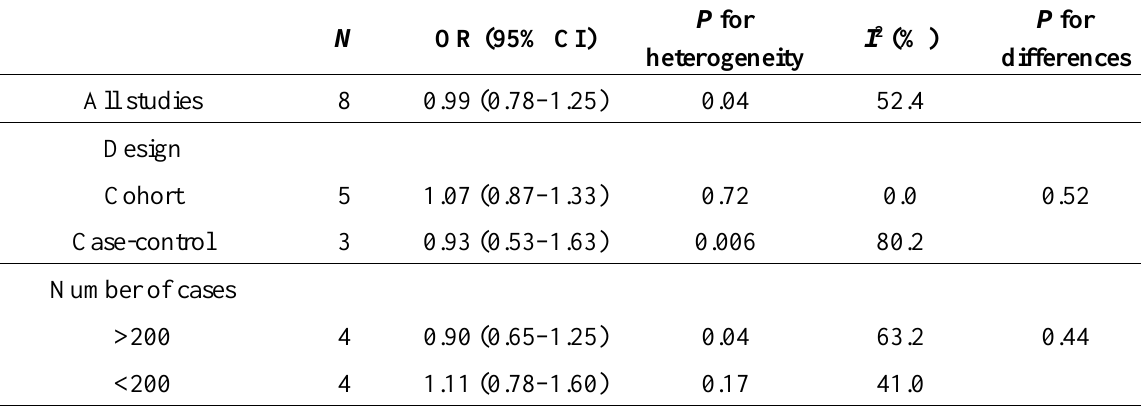
Table 2. Stratified analysis on the association of green tea consumption (highest versus non/lowest) and risk of pancreatic